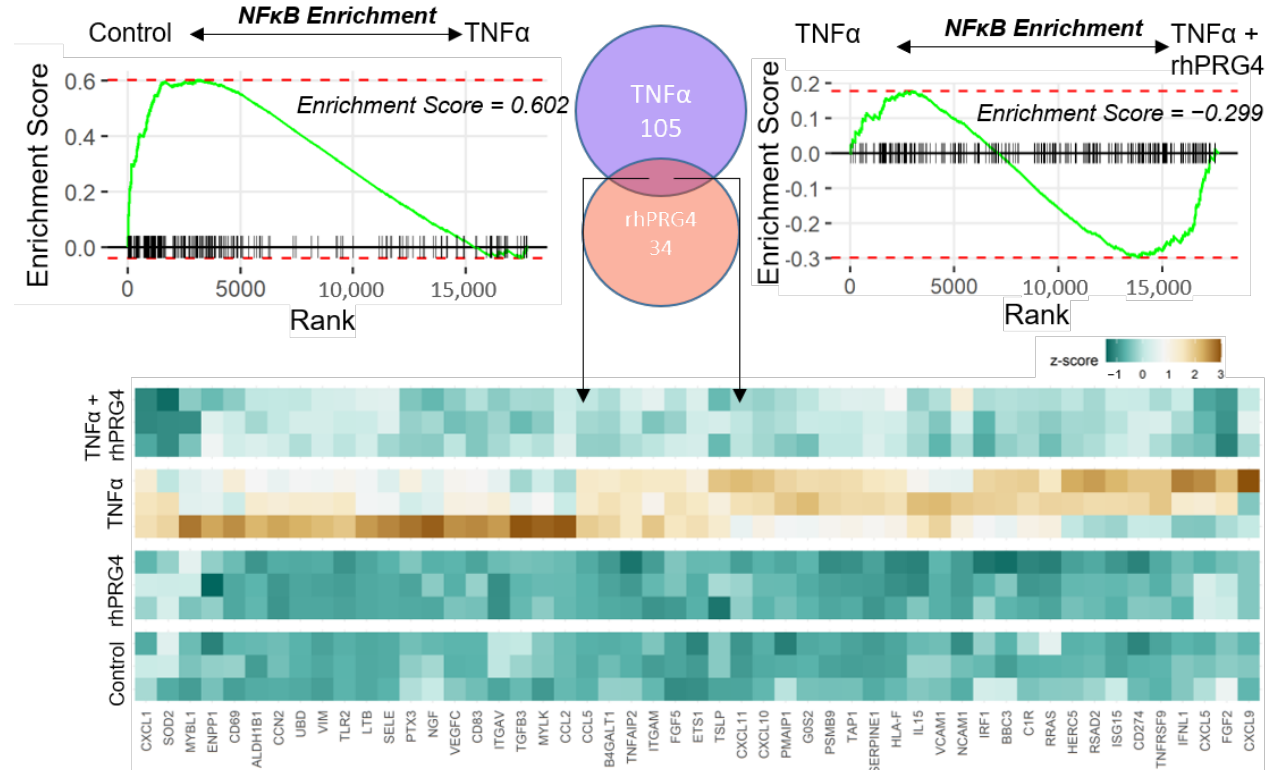
Figure 3. Gene Set Enrichment Analysis diagram shows the enrichment of NF κ B complex genes in the up-regulated genes on TNF α treatment and the relative enrichment in down-regulated genes upon rhPRG4 application on TNF α treatment. The Venn diagram shows the number of NF κ B genes exclusively highly down-regulated by rhPRG4 and up-regulated by TNF α , according to the GSEA leading edges. The common set of genes in the intersection are represented in the heatmap showing the regulation by TNF α and rhPRG4.